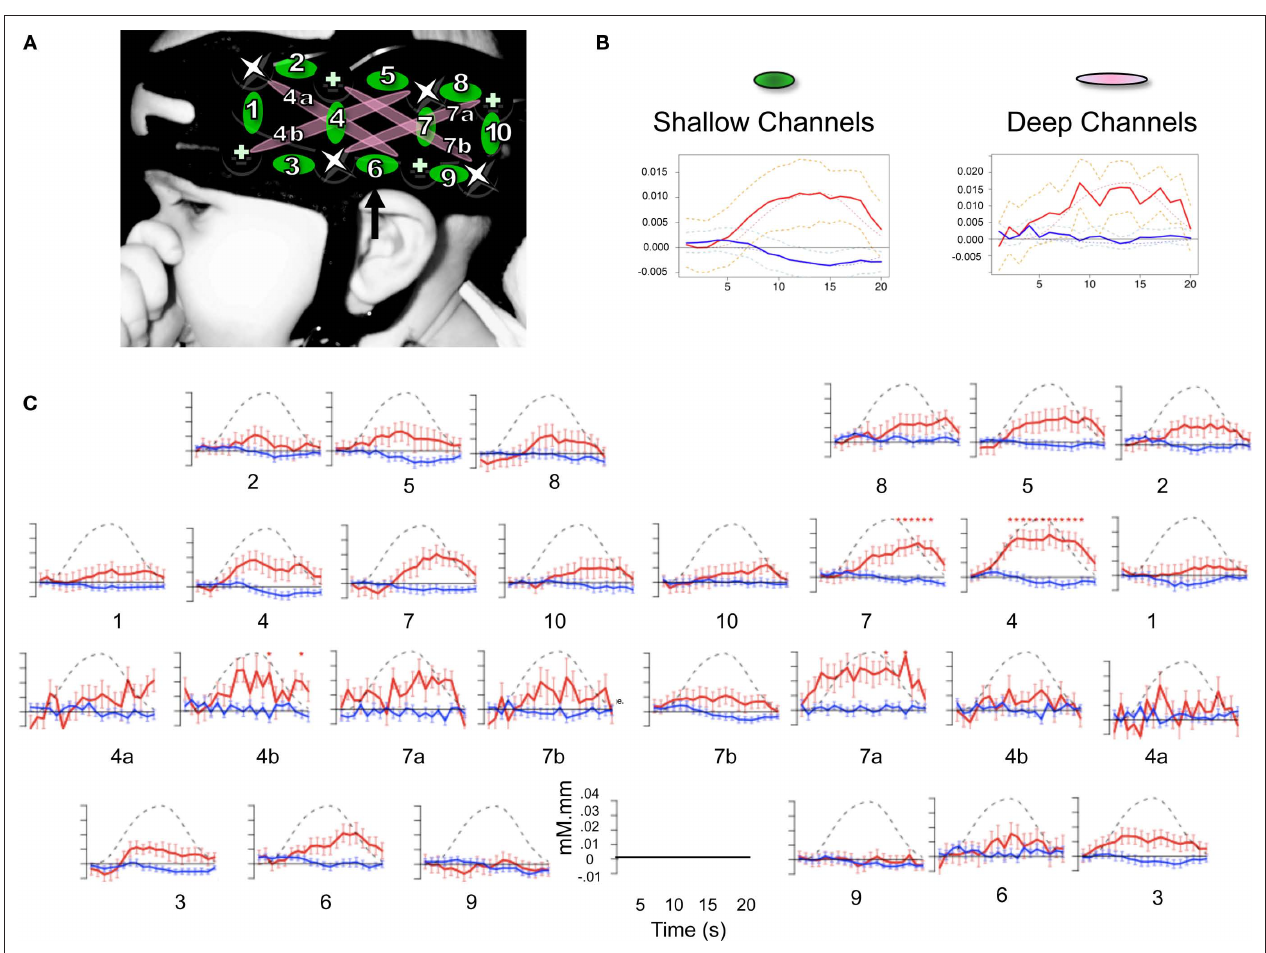
shallow and deep channels; in red oxy-Hb, in blue deoxy-Hb; dashed lines = 95% confidence intervals, dotted lines = the canonical HRF model. (C) Time course of Hb changes in all 28 channels collapsing across the conditions. Stars indicate a significant difference from zero (FDR corrected